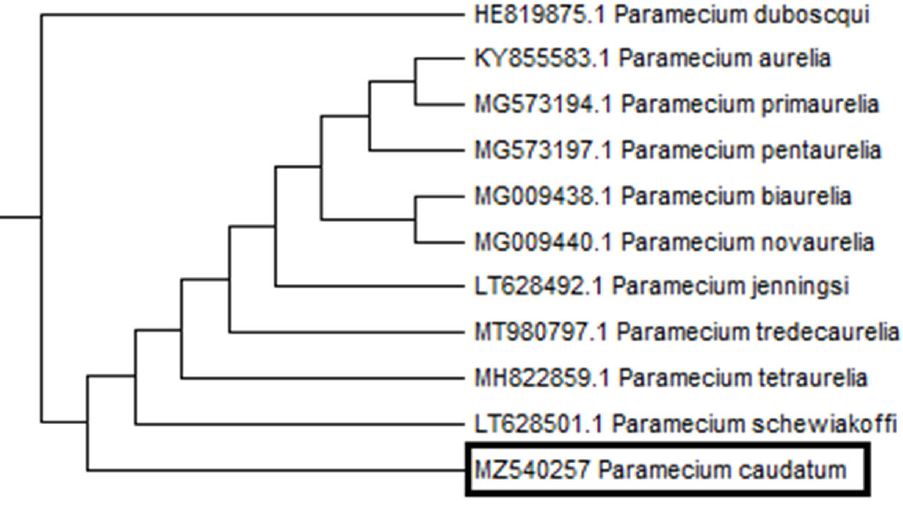
Figure 2. Phylogenetic tree of Paramecium caudatum with other species of genus Paramecium . The corresponding nearest sequencing was retrieved from NCBI database and tree was constructed by using Tree View X software. Paramecium duboscqui was taken as outgroup.